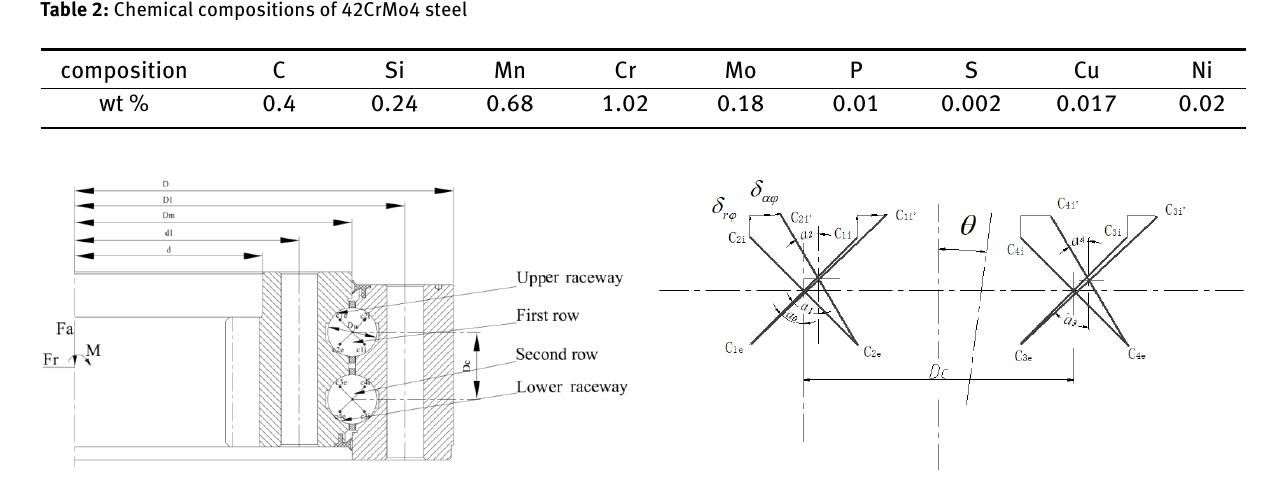
centers of the raceway groove curvature of the outer ring before loading. The centers of the upper and lower raceway groove curvatures of inner ring are denoted by C 1 i ′ , C 2 i ′ , C 3 i ′ and C 4 i ′ respectively with loading in the final